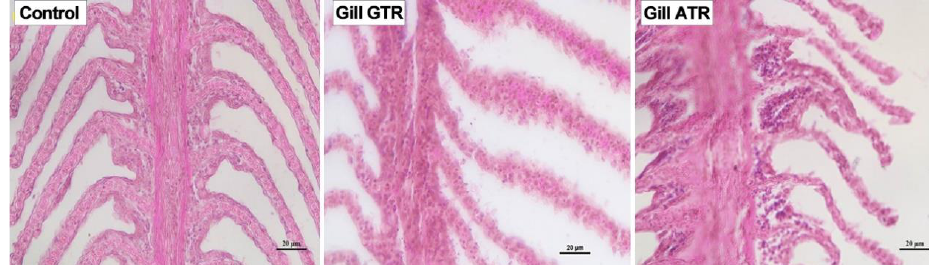
Figure 1. Effect of heat stress on gills of Japanese flounder. GTR, Gradual Temperature Rise; ATR, Abrupt Temperature Rise.